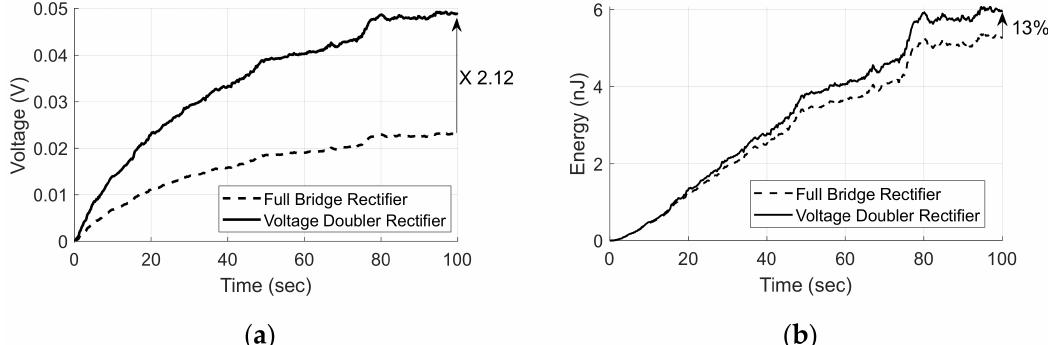
Figure 15. VDR and FBR outputs ( a ) Rectifier voltage; ( b ) Charged energy.